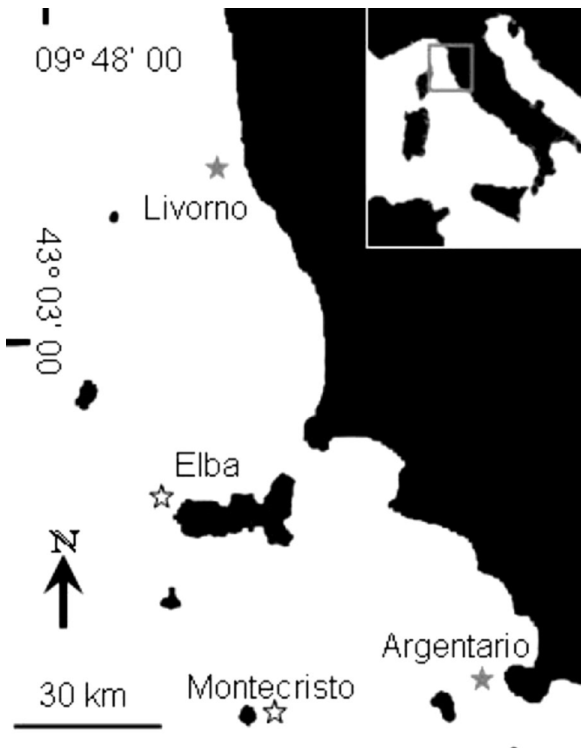
Fig. 1. – Map of the study sites. White stars, reference sites; grey stars, stressed